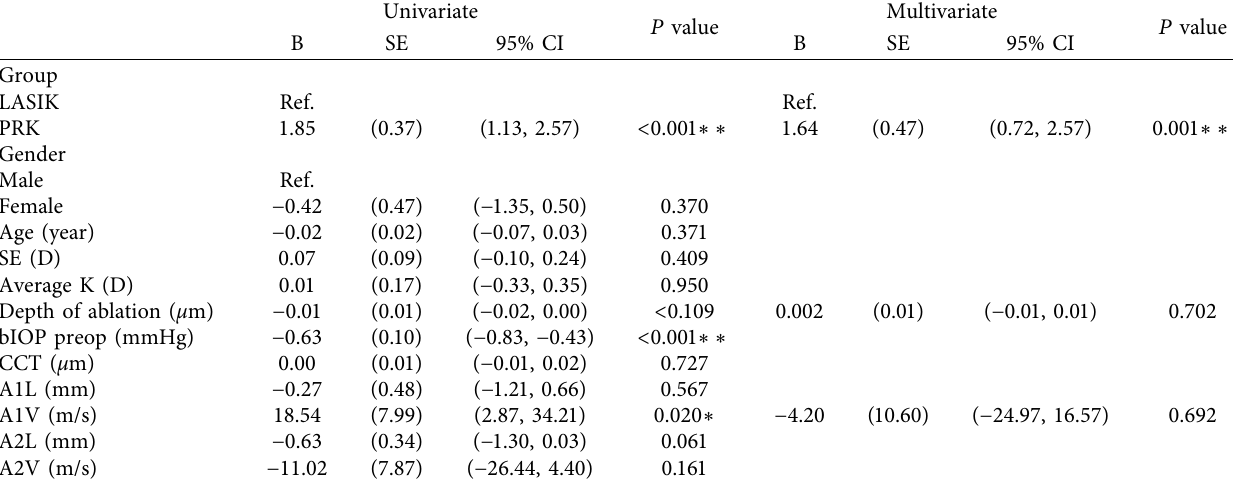
Table 4: Potential factors affecting the changes in bIOP after FS-LASIK and TPRK were analyzed with marginal linear regression models using the